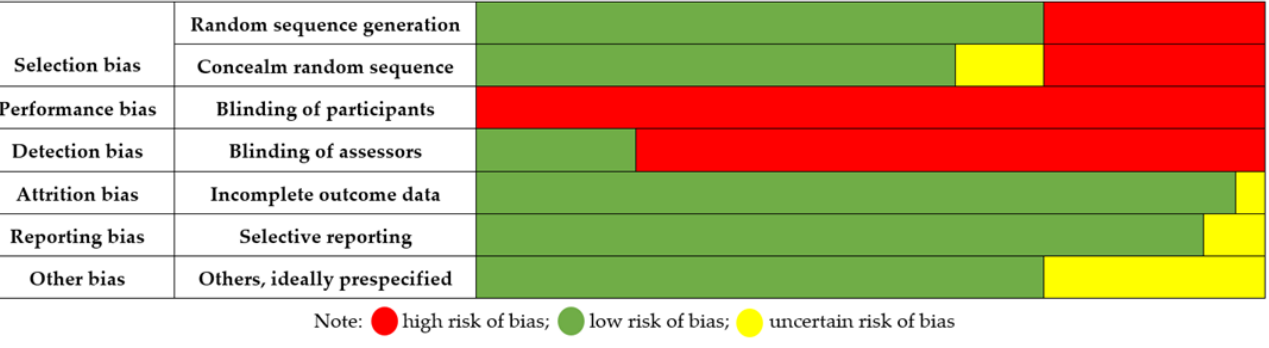
Figure 2. Cochrane risk of bias tool assessment .